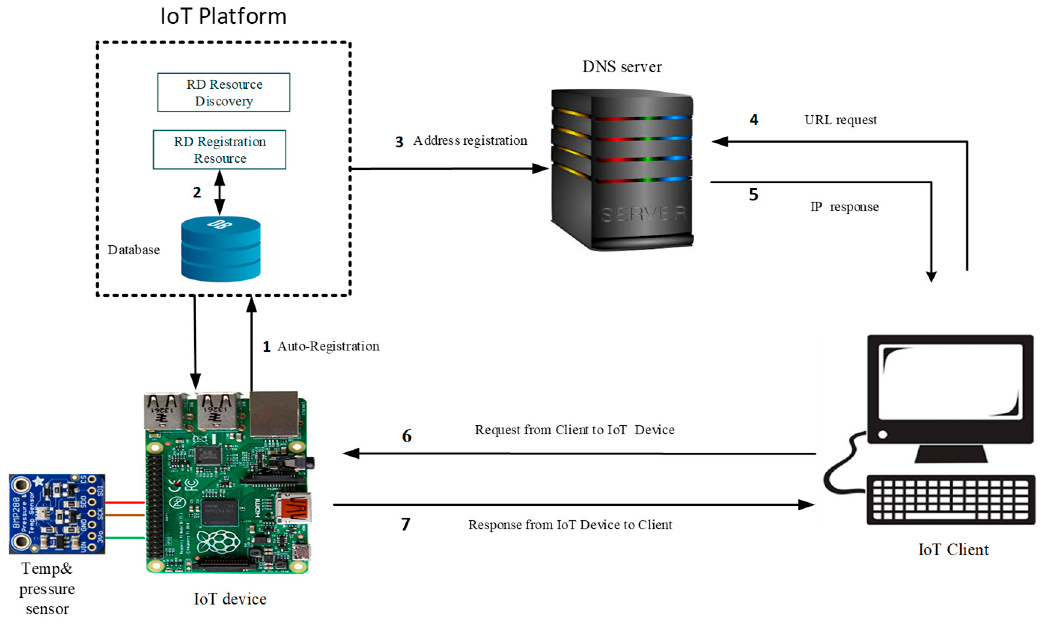
Figure 1. Proposed system architecture for auto-registration and resource discovery.